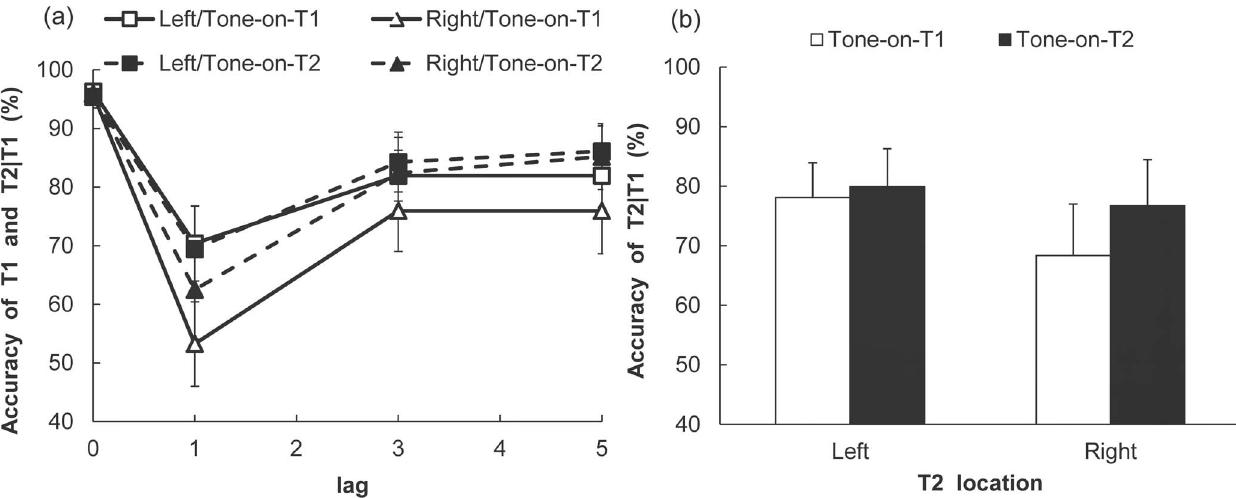
Figure 3. Performance onT1 and T2 identification in Experiment 1B. (a) T1 accuracy and T2 accuracy (given that T1 is correct) in each of the Tone, Visual field, and Lag conditions. (b) T2 accuracy (given that T1 is correct) in each of the Tone and T2 visual field conditions. Vertical axes indicate T2 identification accuracy (percent correct). Error bars represent standard errors of the mean ( n =9).